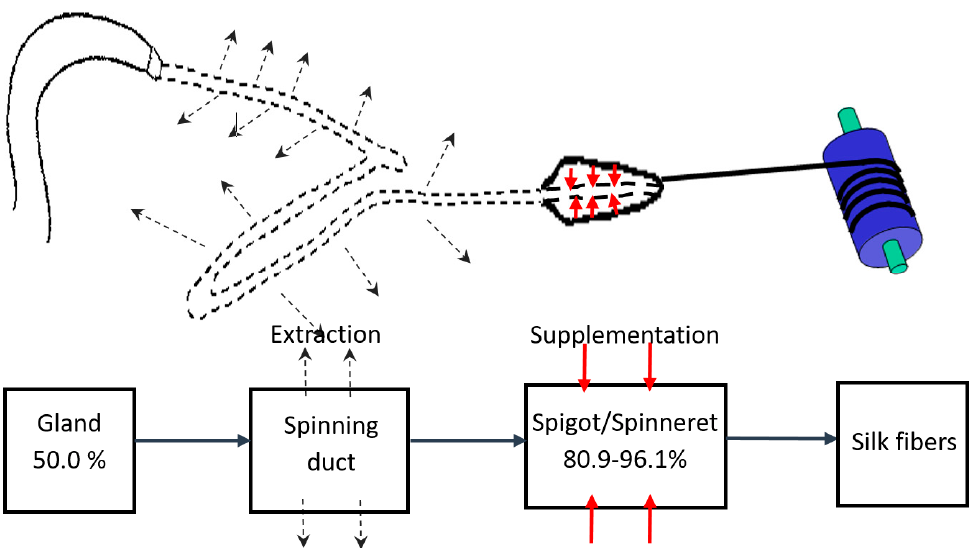
Figure 3. Schematic of the proposed major ampullate silk spinning model for N. pilipes. The liquid content of the silk dope initially decreases as it passes through the spinning duct (liquid extraction; dashed line), and then increases again at the spigot (liquid supplementation; red line) upon silk thread formation.